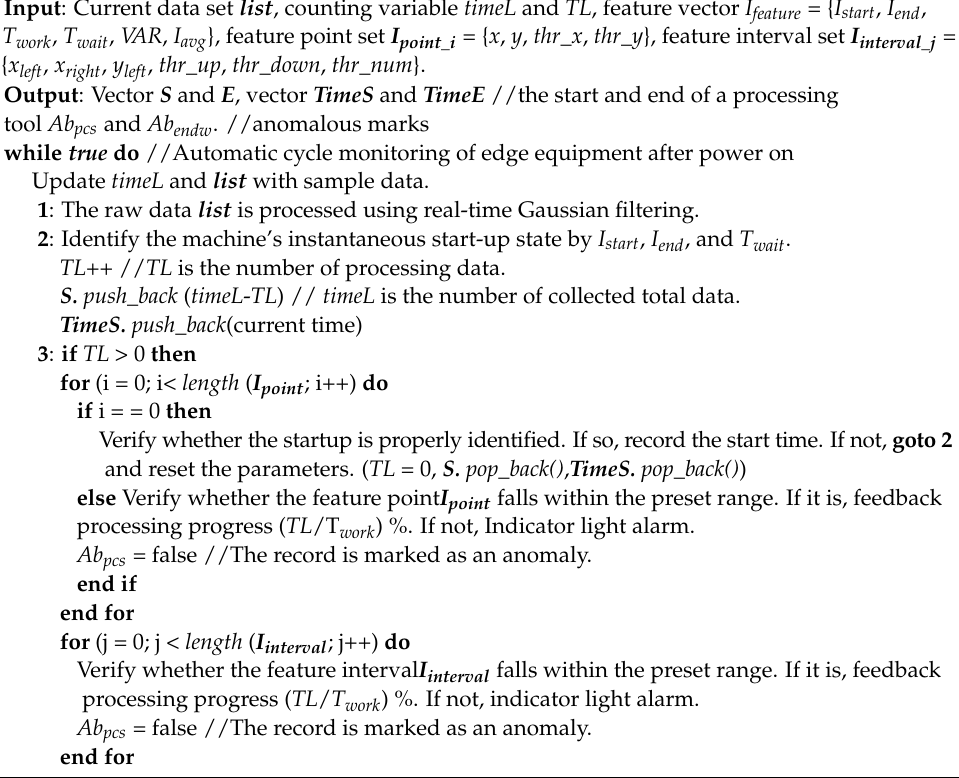
Algorithm 1 : Pseudo code of real-time monitoring.